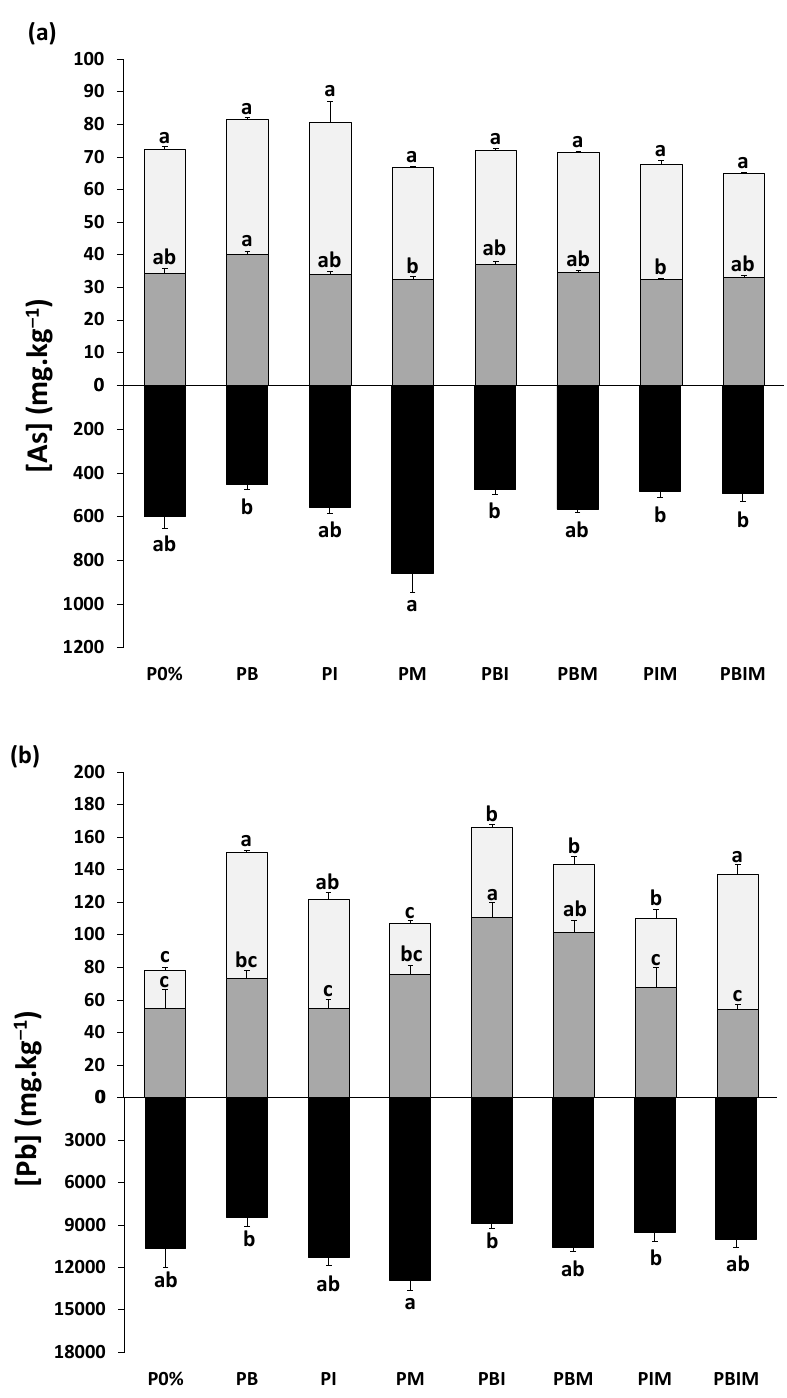
Figure 3. ( a ) Arsenic (mg · kg − 1 ) and ( b ) lead (mg · kg − 1 ) concentrations in roots (black box), stems (gray box) and leaves (white box) determined after 60 days of Salix triandra growth (T60) in the eight studied treatments. Different letters indicate significant difference among the treatments ( p < 0.05) ( n = 5). The letter “a” is used for the highest value found. Different treatments with at least one letter in common show no significant difference. Thus, different treatments not having any letter in